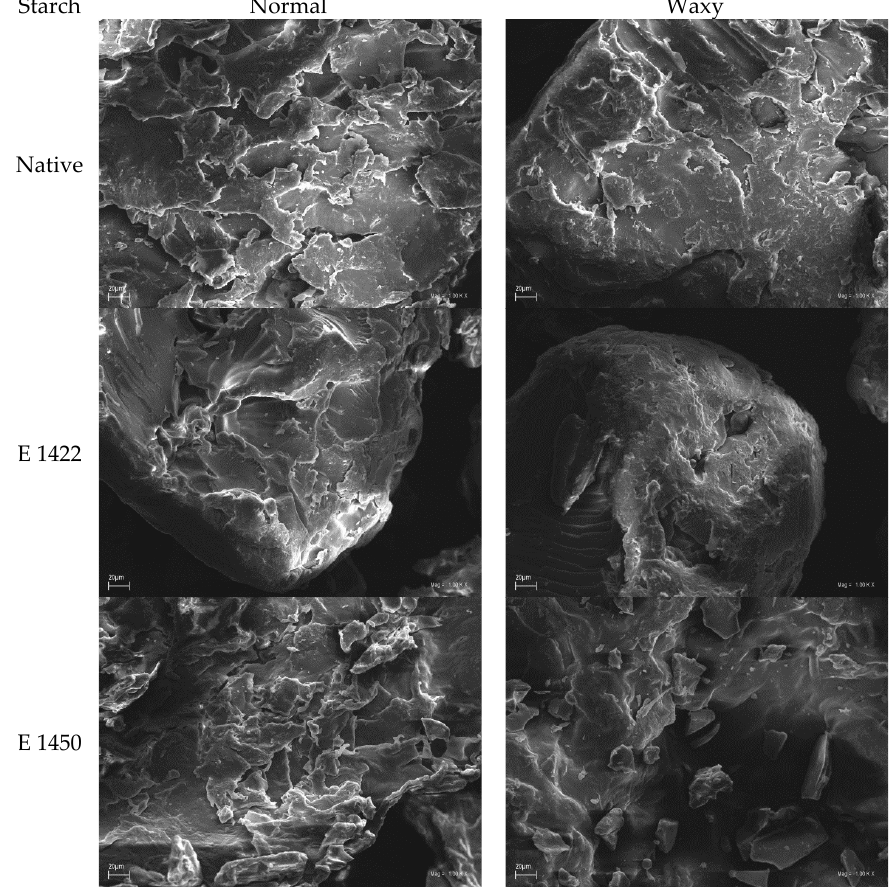
Figure 2. Scanning electron microphotographs of potato starch aerogels.